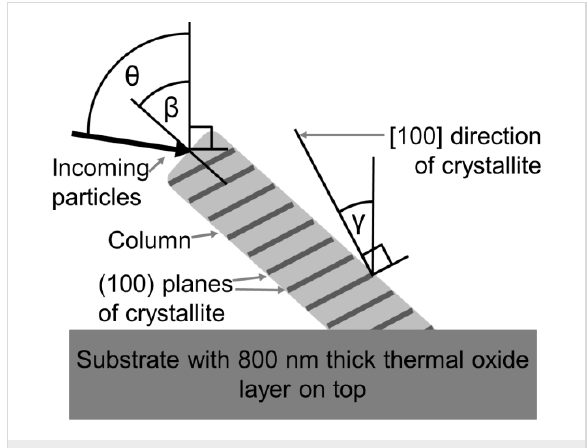
Figure 3: Schematic illustration of a tilted Al column deposited on a thermally oxidized Si substrate at an oblique angle θ = 82°. The column is tilted by the angle β . The [100] directions of the crystallites are represented by γ . All angles are measured with respect to the sub- strate